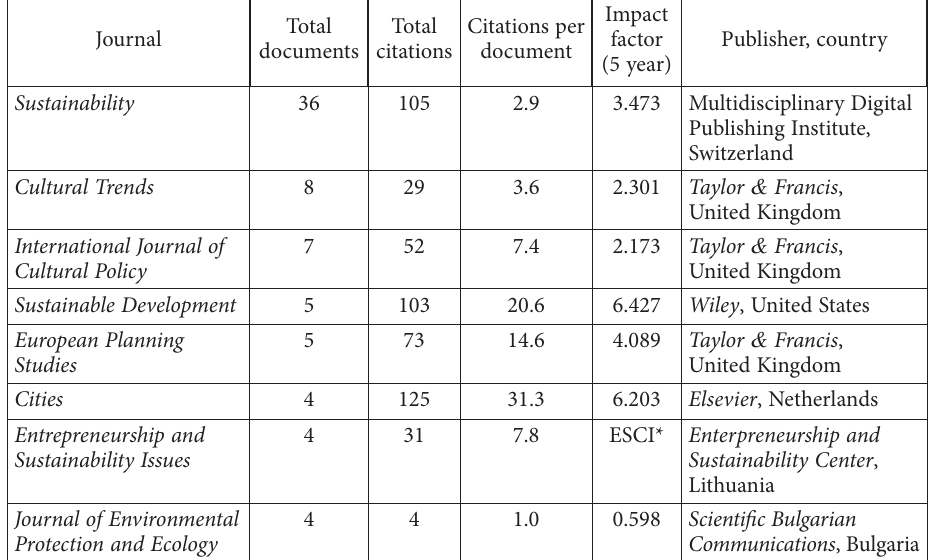
Table 1. Fifteen the most productive journals in the field (source: created by the authors)